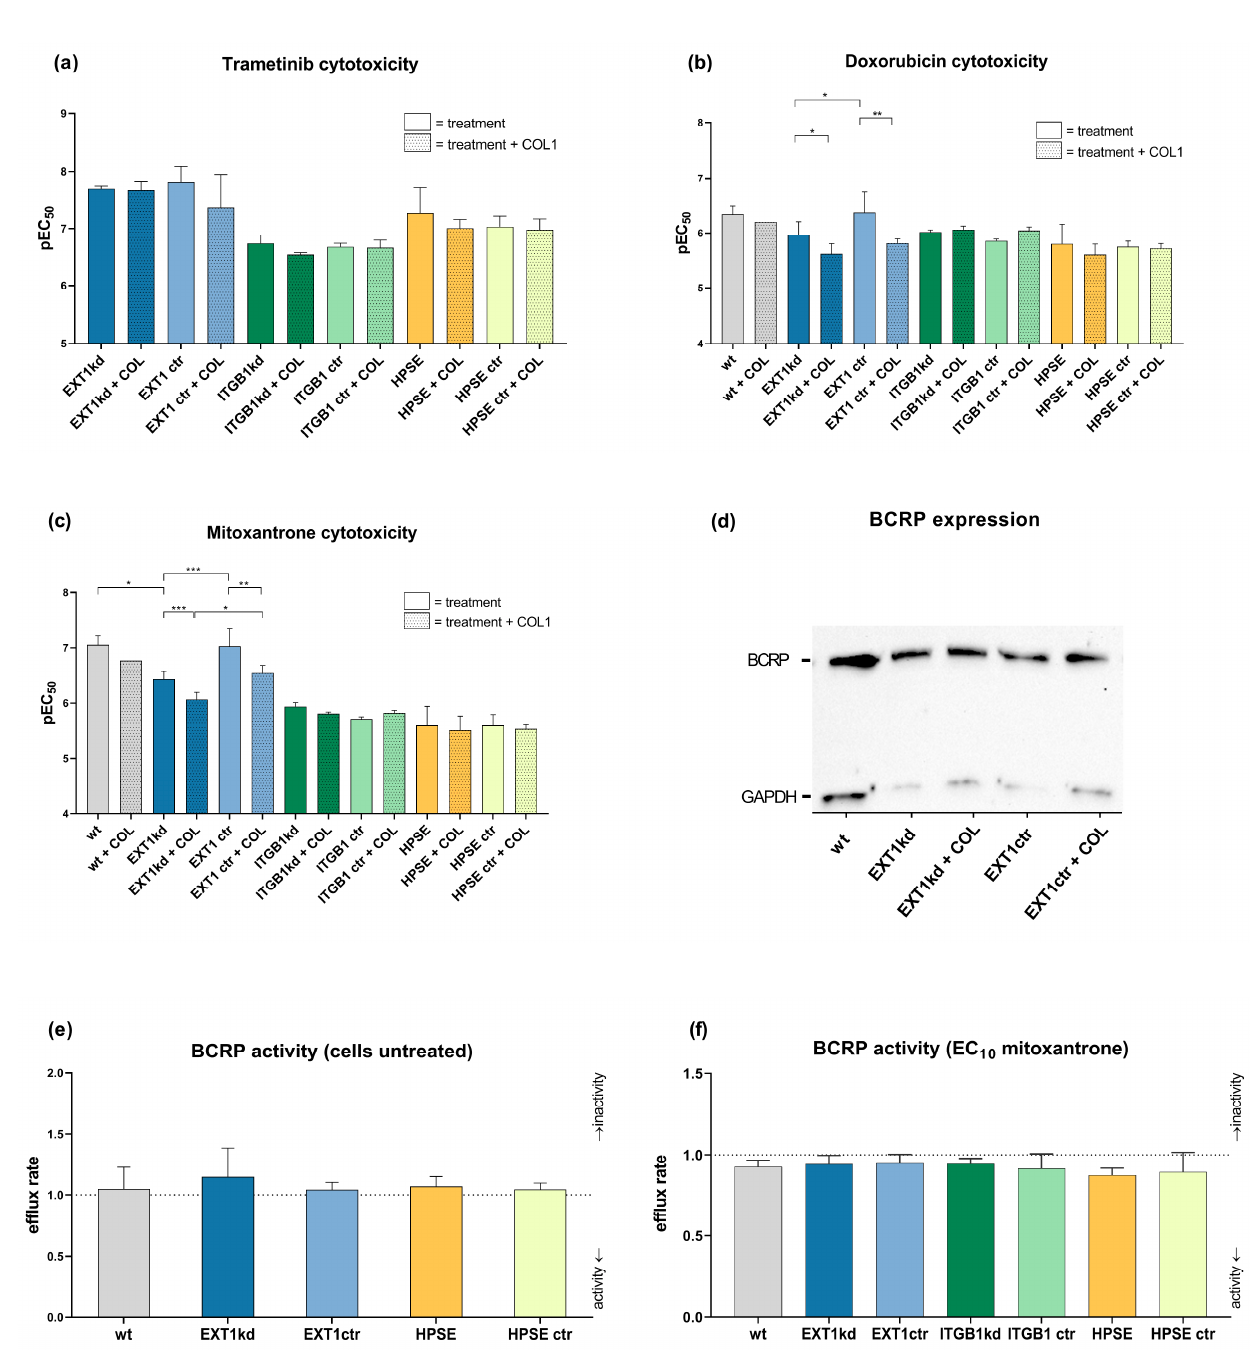
Figure 2. Overview of chemosensitivity (MTT assay) of genetic variants of MV3 cells compared to the corresponding control cell line in relation to COL1 binding. Data were indicated as logarithmic EC 50 (pEC 50 ) values for the treatment with trametinib ( a ), doxorubicin ( b ), or mitoxantrone ( c ). Data indicate that EXT1 knockdown induced a significant resistance formation against doxorubicin and mitoxantrone. ( d ) BCRP transporter expression was detected via Western blot to compare EXT1kd cells and control cells and the impact of COL1. BCRP transporter activity was evaluated by using the pheophorbide assay in the untreated cell variants ( e ) or after stimulating the efflux with mitoxantrone at EC 10 ( f ). Data are represented as mean ± SD (* = p < 0.05, ** = p < 0.01, *** = p < 0.001). Depicted values are given for at least n = 3.